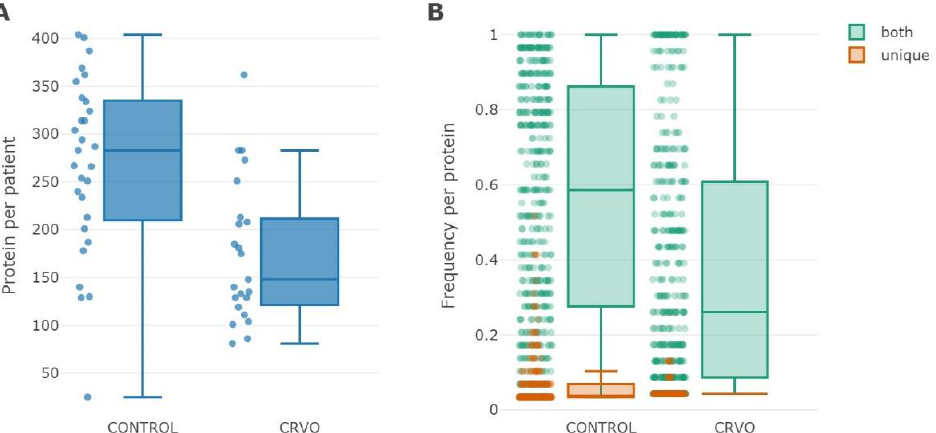
Figure 1. Box-plot of the proteome size ( A ) and frequency ( B ) distribution among subjects in the control and CRVO groups. The median size of individual proteins in the control group was found to be 283 (with a q 1– q 3 interquartile range between 210–335 proteins; maximal size was 404 proteins), whereas the median proteome size in the CRVO group was 148 proteins, with a q 1– q 3 interquartile range of 122–212 proteins and maximal size of 362 proteins (upper fence was 283 proteins). Blue dots indicate personal proteome size ( A ). Frequency distribution of proteins identified within the control and CRVO groups. The median frequency of the majority of group-specific proteins (brown color) was 0.03 (maximum frequency was 0.52, upper fence was 0.1) in the control group and 0.04 (maximum frequency was 0.13) among subjects with CRVO. Proteins of the shared part (green color) of the combined proteome featured a median frequency of 0.58 ( q 1 – q 3 interquartile range of 0.28 – 0.86) in the control group and a median frequency of 0.26 ( q 1 – q 3 interquartile range of 0.09 – 0.61) in the CRVO group ( B ).